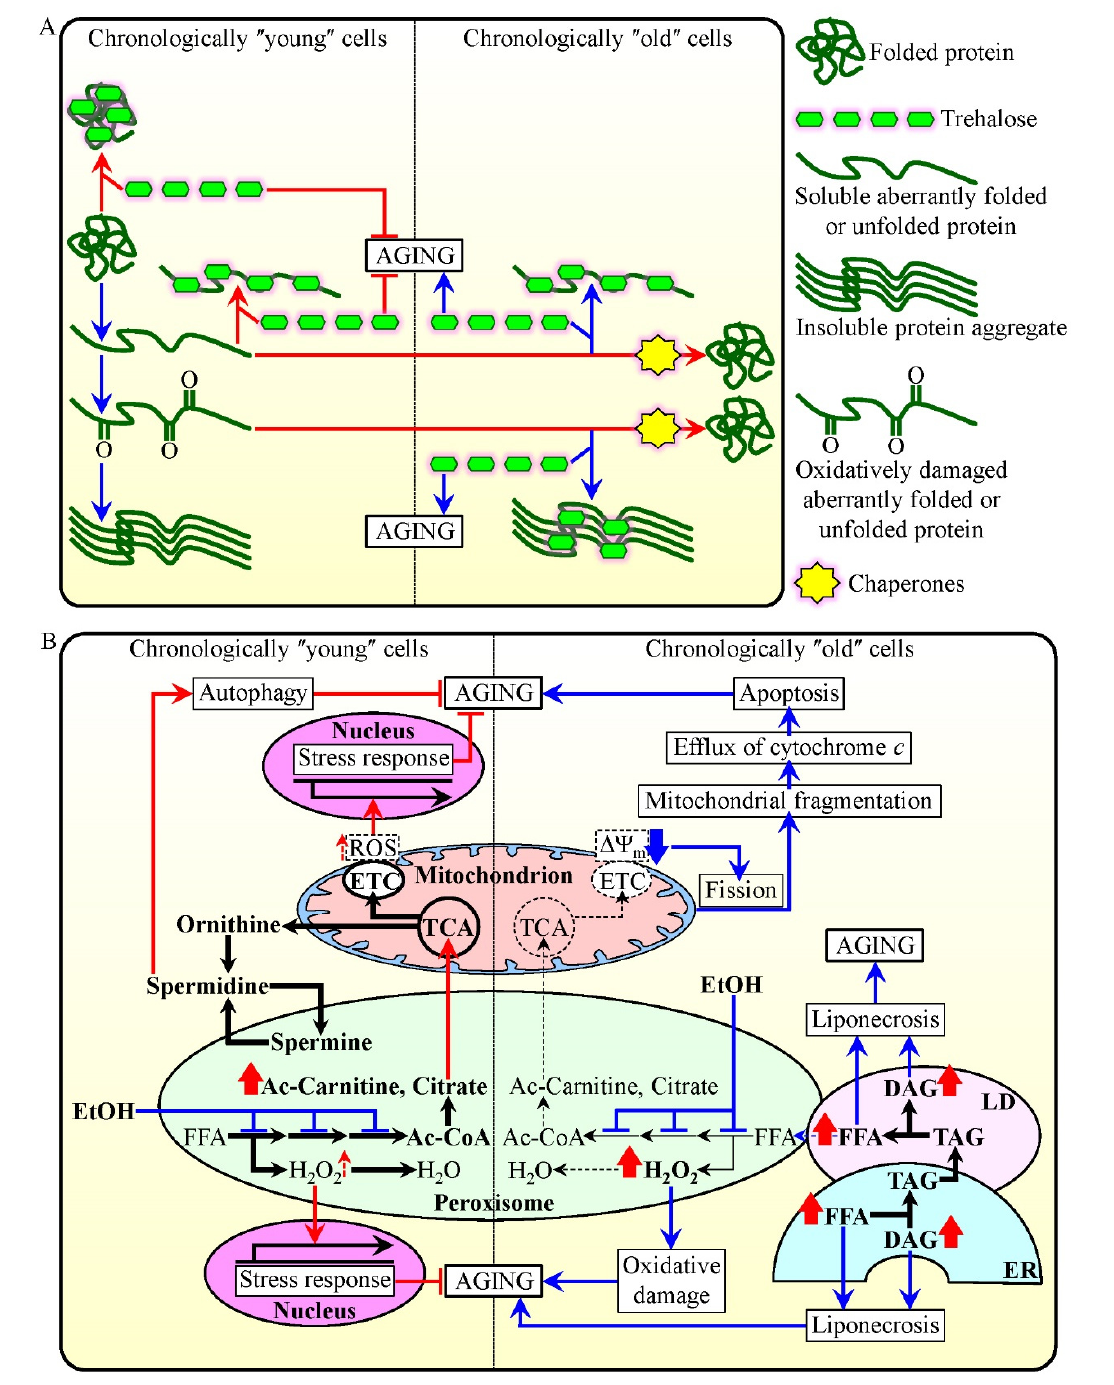
FIGURE 1: Cell-autonomous mechanisms define longevity of chronologically aging yeast by orchestrating trehalose metabolism and met- abolic processes confined to peroxisomes. (A) A model for molecular mechanisms through which trehalose regulates the process of cellular aging in yeast by modulating protein folding, misfolding, unfolding, refolding, oxidative damage, solubility and aggregation in chronologically ″young″ and ″old″ cells. (B) A model for how the age-dependent efficiency of peroxisomal protein import in chronologically aging yeast de- fines the age-related metabolic pattern of peroxisomes, thus impacting longevity-defining processes in other cellular compartments and ultimately establishing a pro- or anti-aging cellular pattern. Activation arrows and inhibition bars denote pro-aging processes (displayed in blue color) or anti-aging processes (displayed in red color). Please see text for additional details. Ac-Carnitine, acetyl-carnitine; Ac-CoA, ace- tyl-CoA; DAG, diacylglycerol; ER, endoplasmic reticulum; ETC, electron transport chain; EtOH, ethanol; FFA, non-esterified (″free″) faHy ac- ids; LD, lipid droplet; ROS, reactive oxygen species; TAG, triacylglycerols; TCA, tricarboxylic acid cycle; ΔΨ m , electrochemical potential across the inner mitochondrial